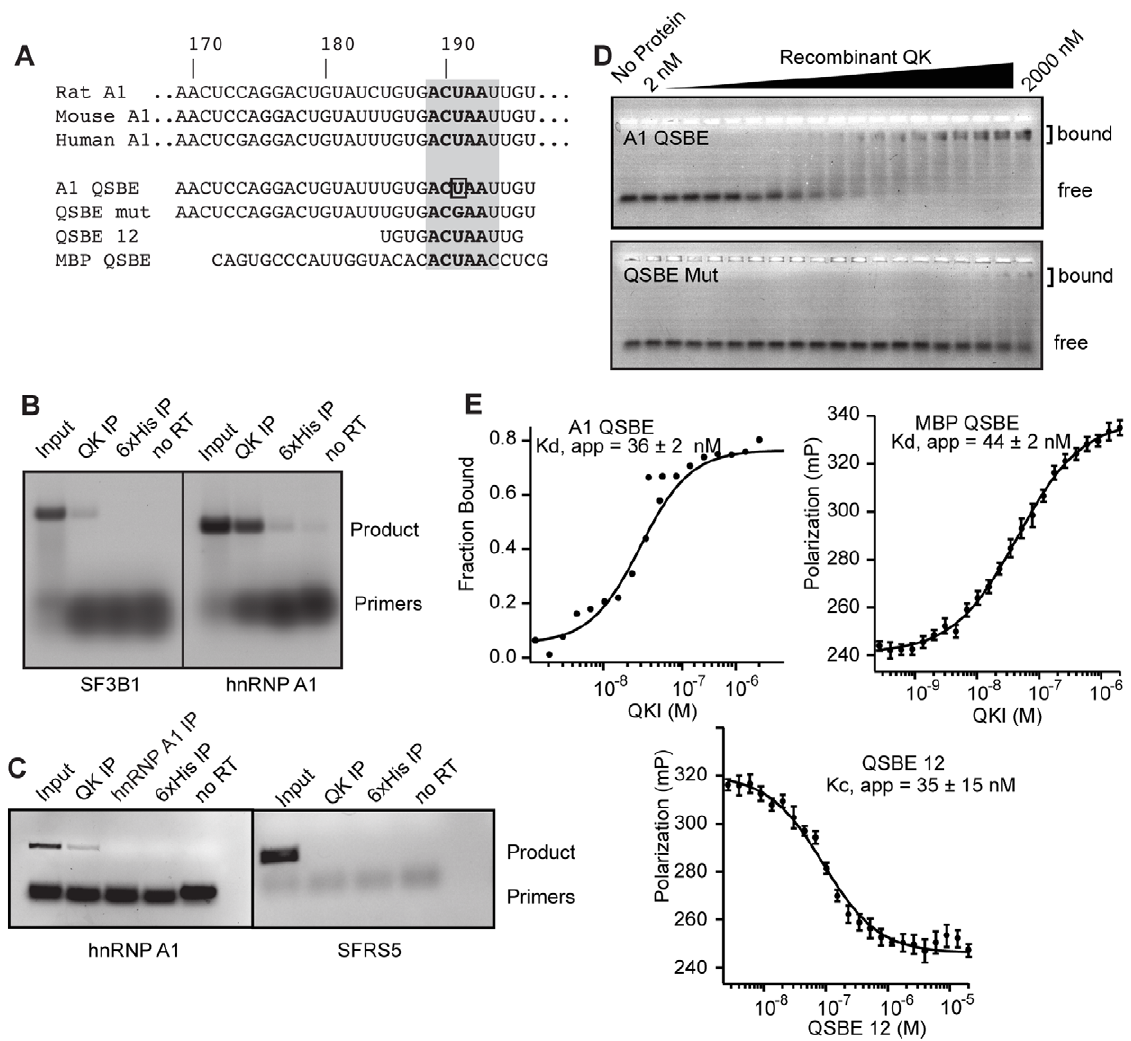
Figure 2. QK binds to an element in the Hnrnpa1 3 9 UTR. (A) Mouse, rat, and human Hnrnpa1 3 9 UTRs contain the ACUAA element in a conserved UTR region. Also included are the sequences analyzed by gel shift and fluorescence polarization assays, including the U to G point mutant, and the Mbp QSBE for comparison. (B) Hnrnpa1 mRNA co-immunoprecipitated with QK from mouse brain lysate. Lanes are as indicated. (C) Hnrnpa1 mRNA co-precipitated from a lysate prepared from formaldehyde crosslinked mouse brain tissue. Lanes are as indicated. Products were detected